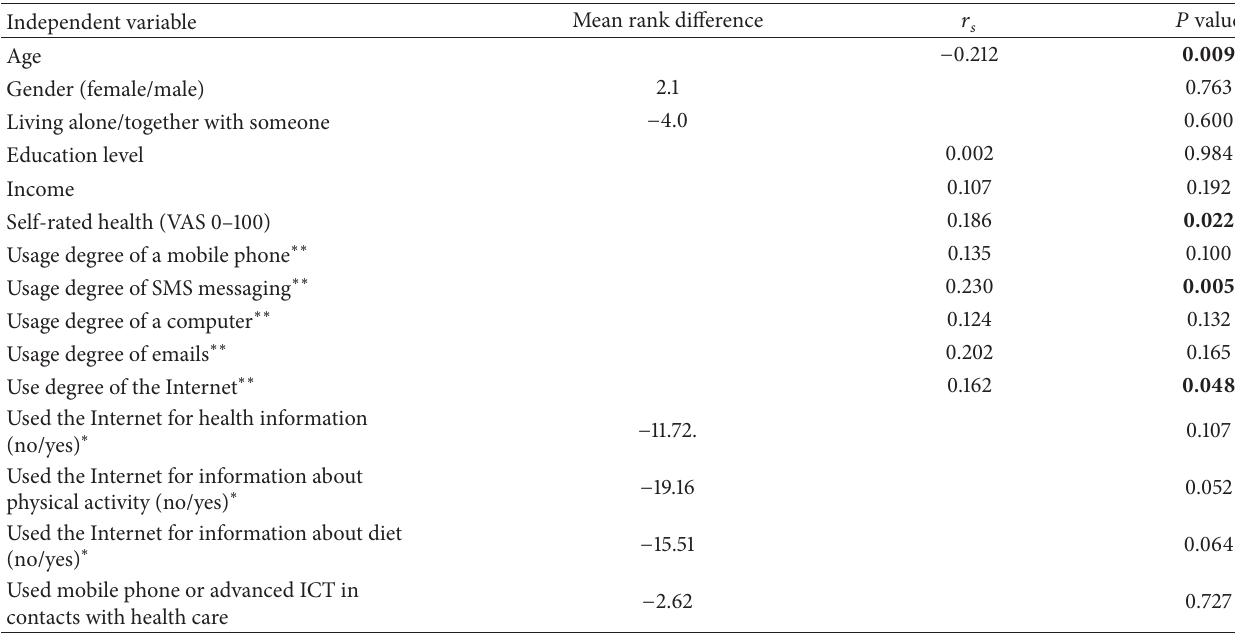
Table 4: Associations between PIADS total score for the future mobile health applications scenario and respondents’ profile variables (𝑛 = 150)